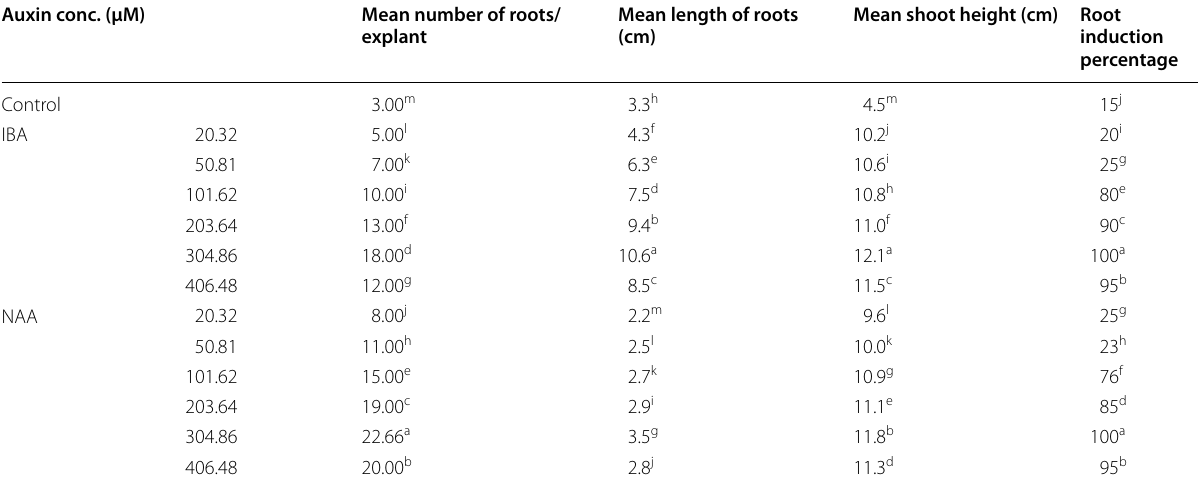
Table 6 Effect of IBA and NAA different concentrations on root formation of L.